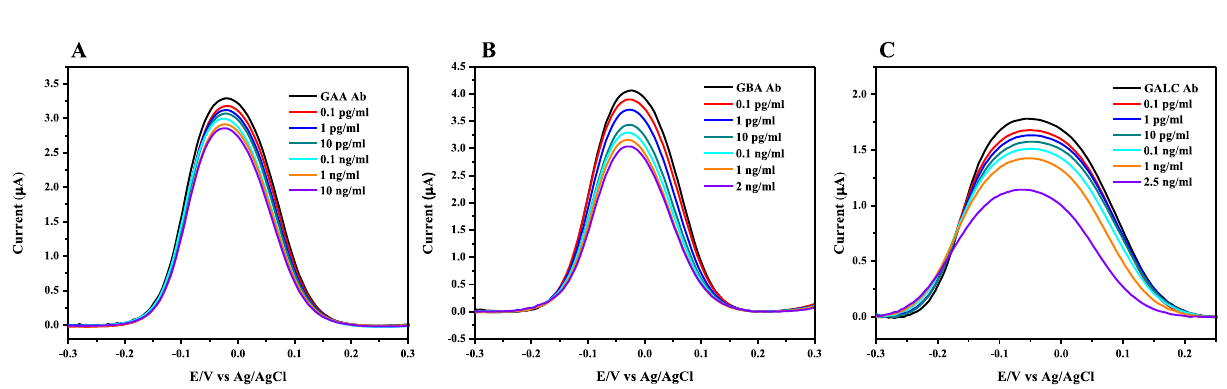
Figure 3. Plot of the immunosensor response ((i° − i)/i° %) versus the binding time in minutes of the immunosensors with their specific proteins for GAA, GBA and GALC.